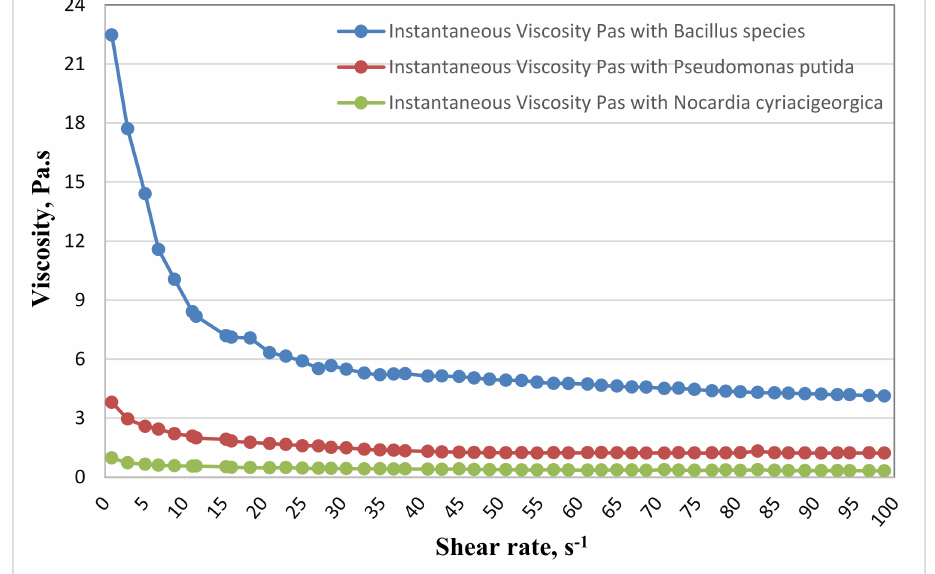
Figure 1. Reduction in viscosity of crude oil treated with Bacillus species, Pseudomonas putida , and Nocardia cyriacigeorgica at 37 ◦